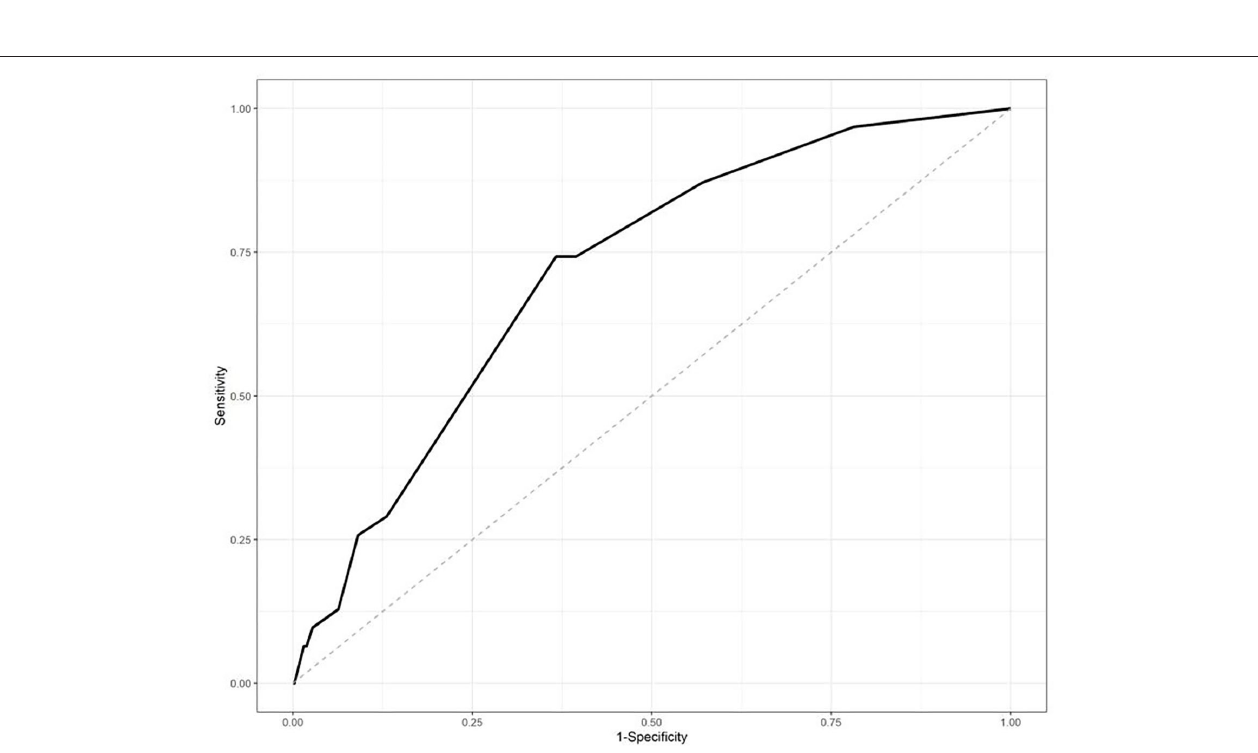
FIGURE 2 | Receiver-operator curve (ROC) analysis of the risk scores in the testing datasets. The area under the curve was 0.7152.